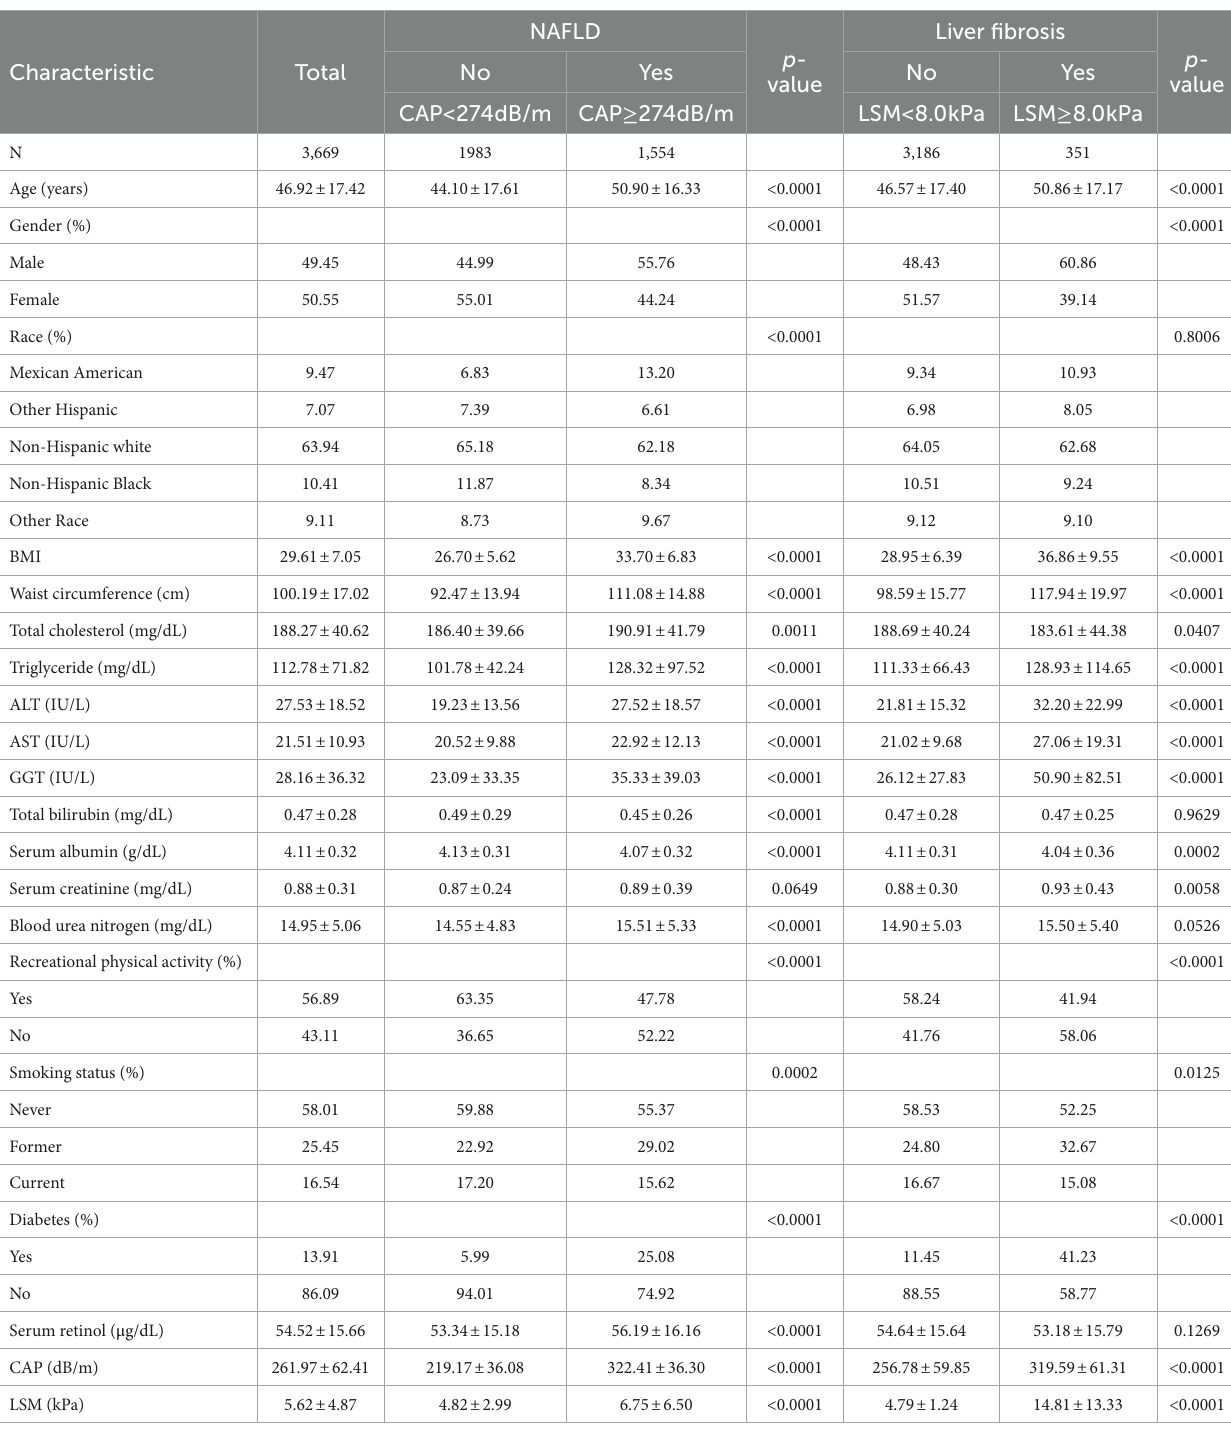
TABLE 1 Weighted characteristics of the study sample based on NAFLD and liver fibrosis